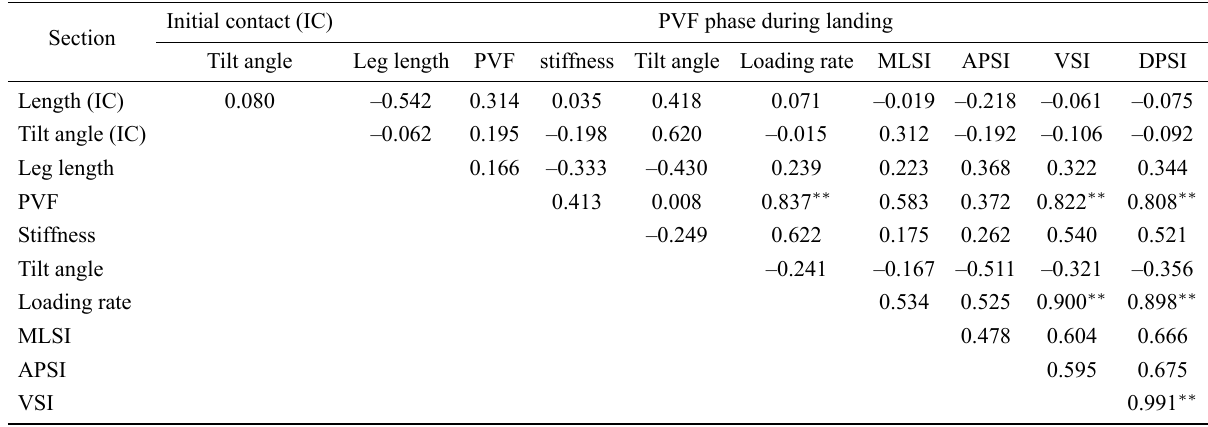
Table 2. Results of correlation ( r